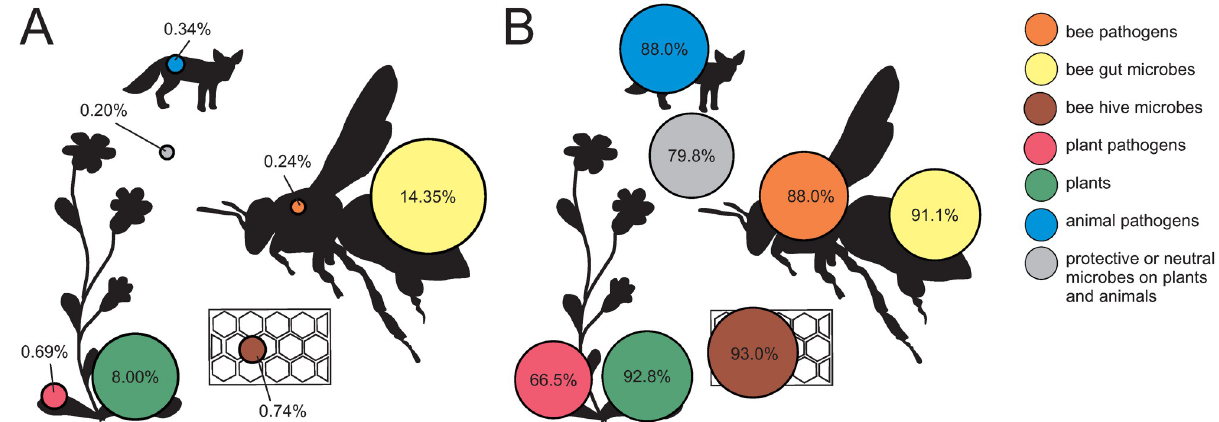
Fig 3. The abundance and frequency of ecological groups of microbes and plants based on DNA in honey. Shown are microbe genera detected with a frequency of at least 0.01% of mean RRA across taxa based on metagenomics, as grouped based on their role for honeybees and in the environment (Table 1). Also shown are values for plant genera detected with a mean RRA of at least 0.01%. In panel A, we show the average RRA of the genera summed across taxa within each group. In panel B we show the average FOO% across these genera. The size of the circles are scaled according to the value of RRA and FOO%,